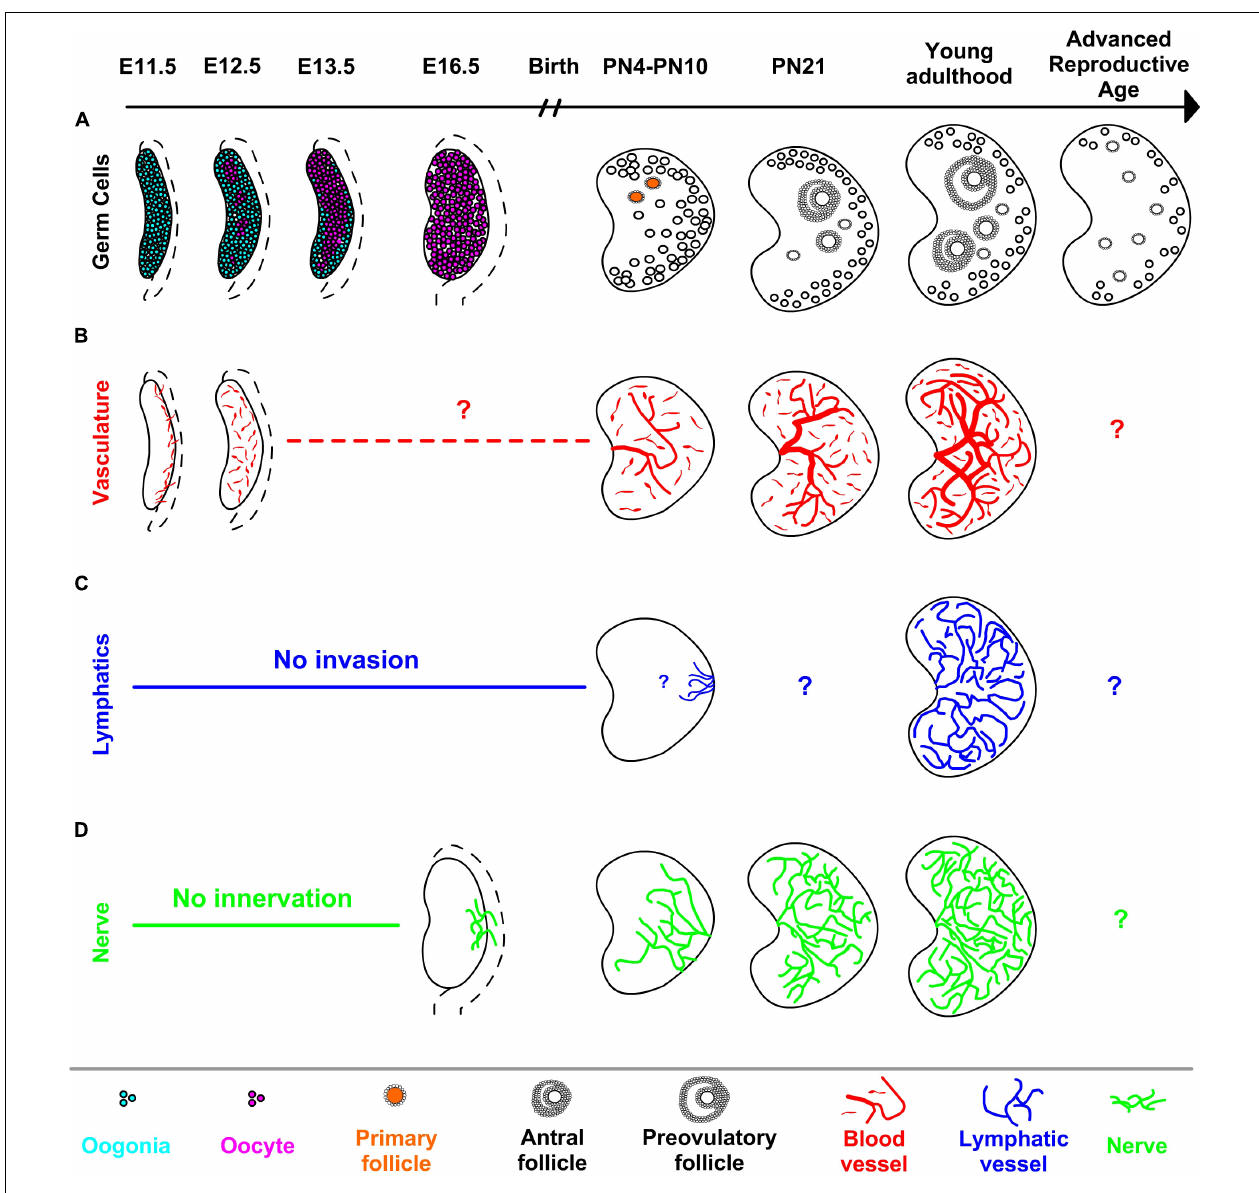
FIGURE 1 | Main developmental events of the ovary organogenesis uncovered by 3D imaging in mice. (A) Following the localization in the gonad, germ cells undergo meiosis (in magenta) asynchronously starting as early as E12.5 in the anterior-medial region of the ovary. Germ cells located in the peripheral-posterior part of the ovary maintain their pluripotency (cyan) and initiate the meiosis later and by E16.5, all germ cells enter meiosis. Formation of primary follicles (in orange) and the first activation of follicular growth occur in the anterior-dorsal region of the postnatal ovary. While the number of follicles decreases with advanced maternal age, aged ovaries harbor mostly primordial and primary follicles due to the decreased number of later stage follicles. (B) Blood vessels (in red) at the gonad-mesonephros border expand into the gonad at E11.5 and proliferate to establish the blood vessel network of the developing ovary. Although further development of the vascular network in late fetal ovaries is unclear, blood vessels in the postnatal ovaries enter from the hilum and blood vessel diameters and branching increase by adulthood. (C) Lymphatic vessels (in blue) invade the ovary as early as PN10, however, the first point of contact inside the PN10 ovary is unclear with the resolution of micrographs. Similar to blood vessels, the adult ovary contains a complex network of lymphatic vessels. (D) Nerve fibers (in green) in the mesonephros innervate the ovary first from the dorsal side at E16.5, neural projections expand to medulla then cortex by PN4 and the neural network further increases with age. Dashed lines adjacent to fetal ovaries illustrate mesonephros. Question marks in (B–D) refer unidentified geography of related structures at given developmental points in